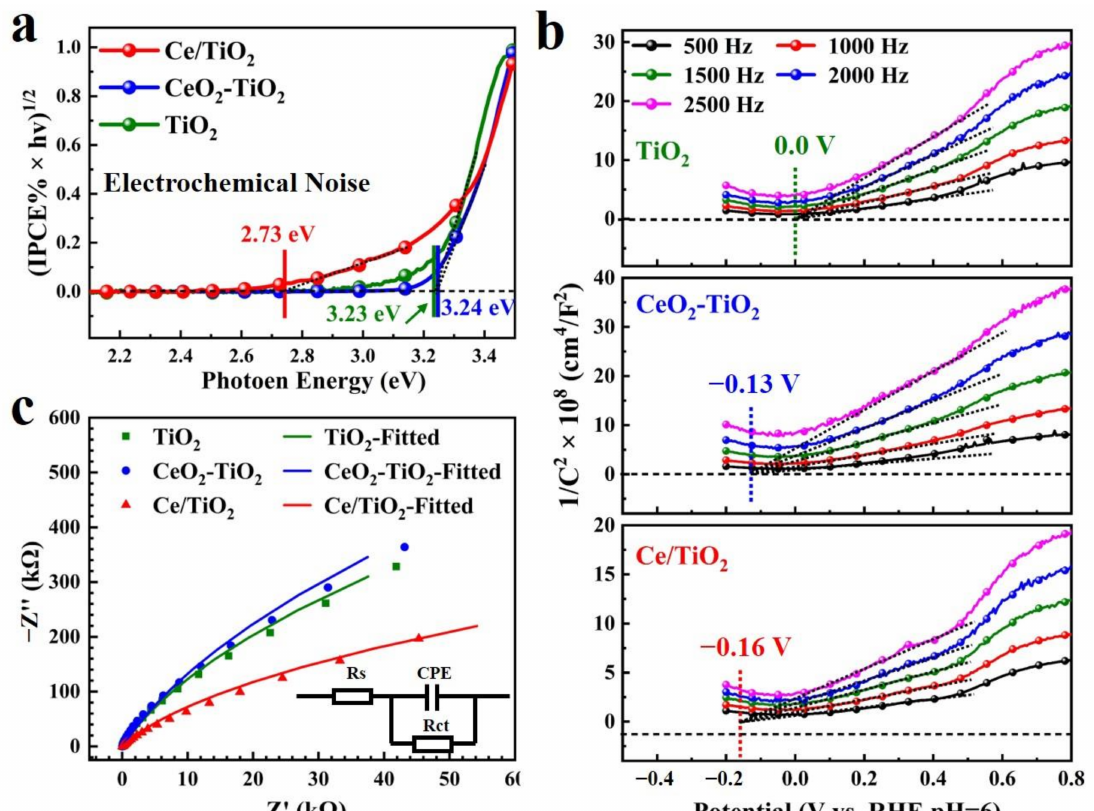
Figure 8. ( a ) The band gap determination extracted from the IPCE spectra as a function of (IPCE% × hv) 1/2 vs. hv; ( b ) Mott–Schottky plots; ( c ) EIS Nyquist plots with the fitted equivalent